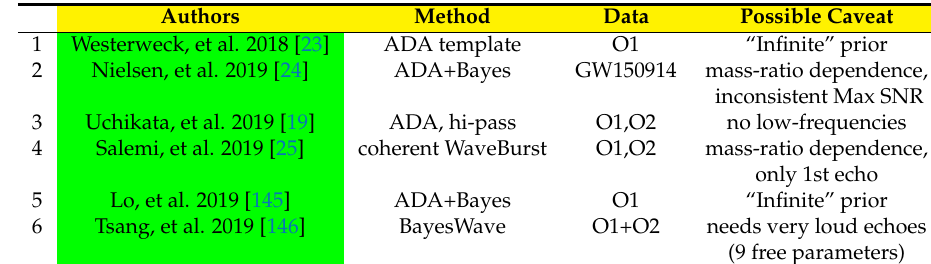
Table 4. Table of failed searches and their possible caveat. “Infinite” prior refers to models that include unphysical non-decaying echoes. As discussed in the text, inclusion of such templates skews any statistical